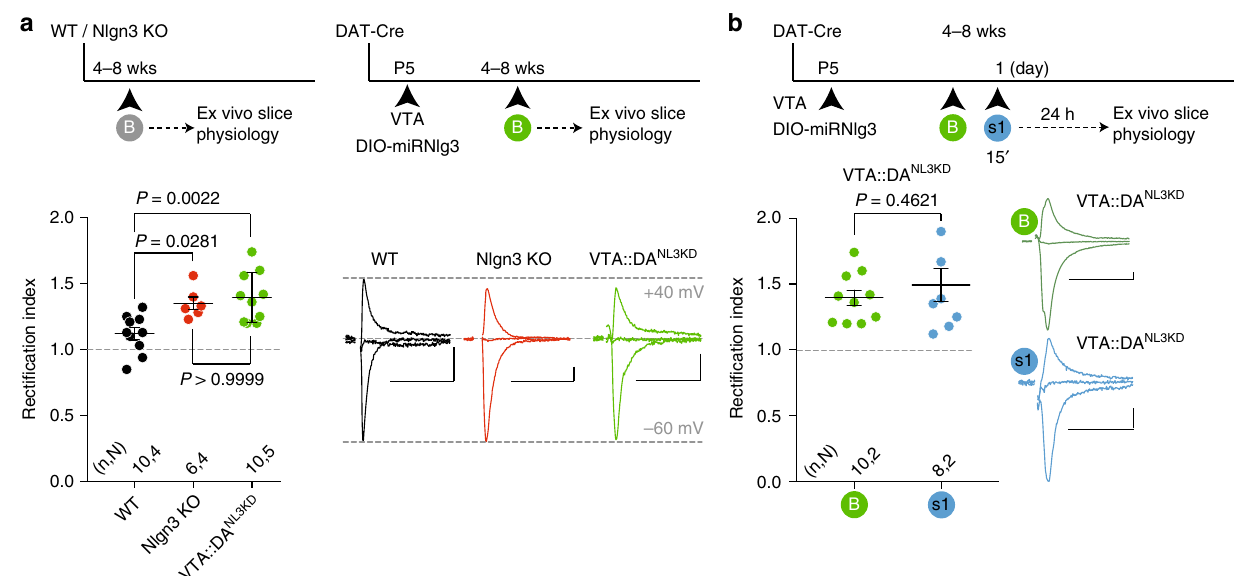
Fig. 8 Aberrant increase of GluA2-lacking AMPARs in Nlgn3 -de fi cient VTA DA neurons. a Top: experimental paradigm. Bottom: scatter plot of recti fi cation index and example traces of AMPAR-EPSCs ( − 60, 0, and 40 mV) measured from adolescent WT, Nlgn3 KO and VTA::DA NL3KD . One-way ANOVA ( F (2, 23) = 8.363, P = 0.0019) followed by Bonferroni post hoc test. b Top: experimental paradigm. Bottom: scatter plot of recti fi cation index and example traces